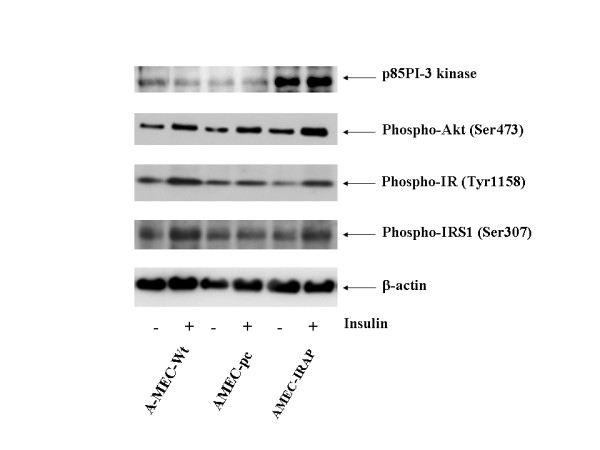
The effect of P-LAP/IRAP transfection on insulin induces activation of the PI3K/AKT pathway in A-MEC cells. The cells were stimulated on 10-7 M insulin for 30 min in serum free medium. In A-MEC-LAP cells, with or without insulin, p85PI3K protein expression was increased compared with those of A-MEC and A-MEC-pc cells. In addition, AKT phosphorylation in the insulin-stimulated A-MEC-LAP cells was stronger compared with those in A-MEC and A-MEC-pc cells. Insulin stimulated IR and IRS1 phosphorylation were observed in all A-MEC, A-MEC-pc, and A-MEC-LAP cells to the same degree.